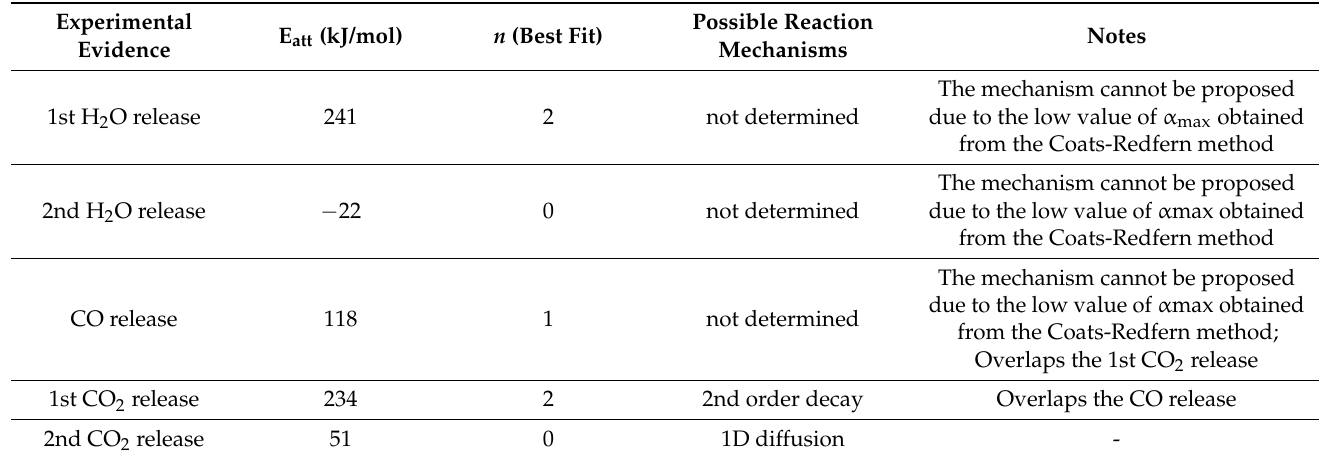
Table 1. Activation energies (E att ) and orders of the reactions ( n ) were evaluated by applying the Coats-Redfern method. The mechanism of reaction was hypothesized, when possible, using the approach described by Dollimore et al.